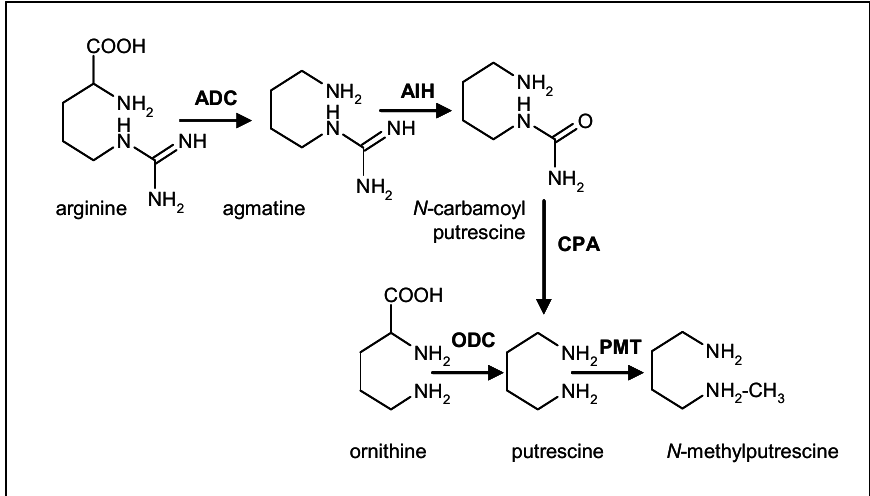
Figure 2. Biosynthesis of N -methylputrescine from arginine and ornithine. ADC: Arginine decarboxylase. AIH: Agmatine iminohydrolase. CPA: